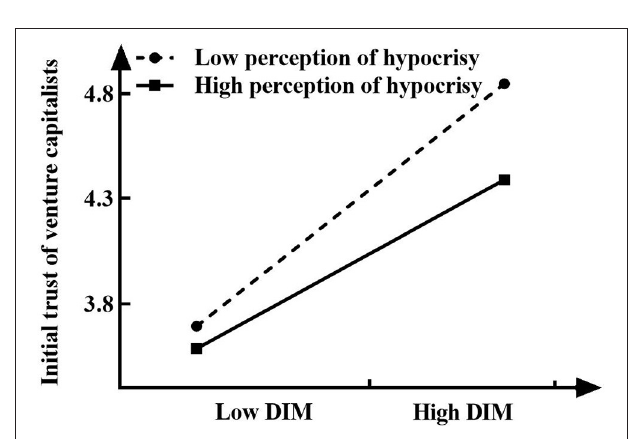
FIGURE 3 | Interactive effect of the defensive impression management strategies and perception of hypocrisy on initial trust of venture